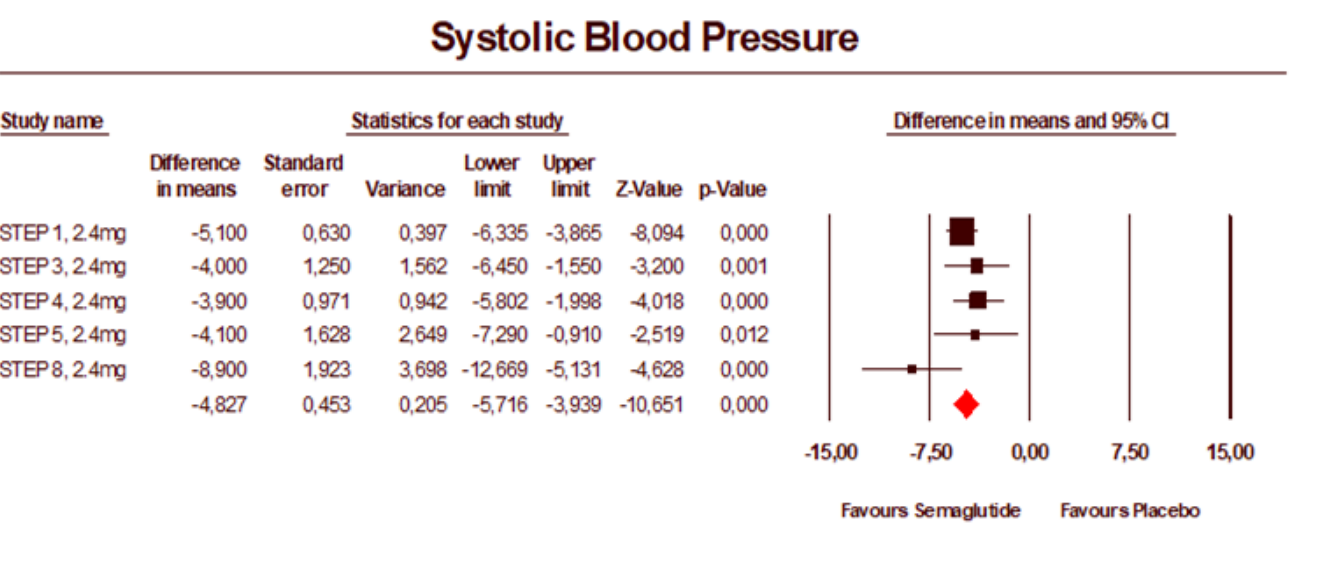
Figure 3. Forest plot of semaglutide vs. placebo showing the pooled weighted mean difference for DBP (random effects model) [18].